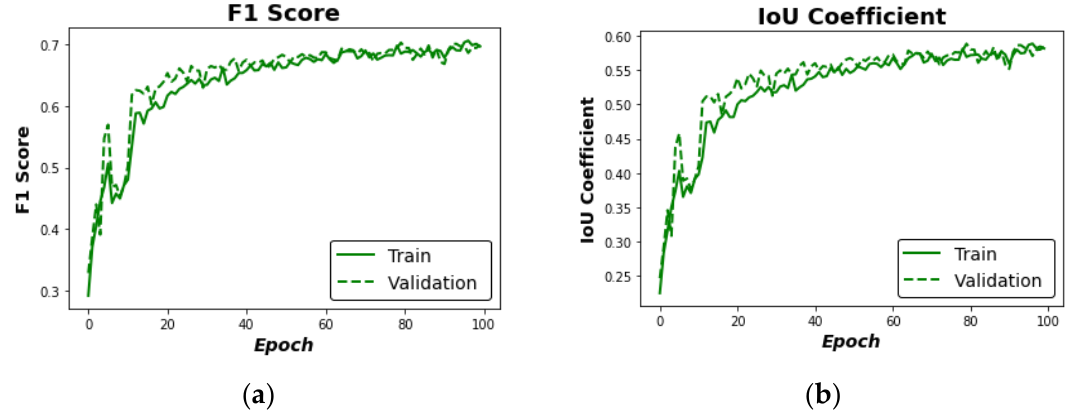
Figure 12. ( a ) U-Net F1 training curve; ( b ) U-Net IoU training curve.